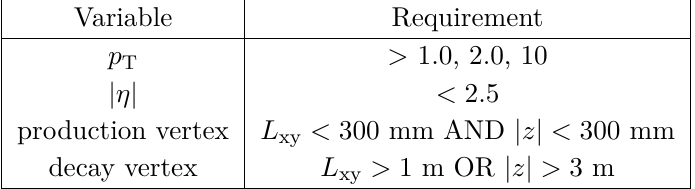
Table 4. Track criteria for minimum bias background